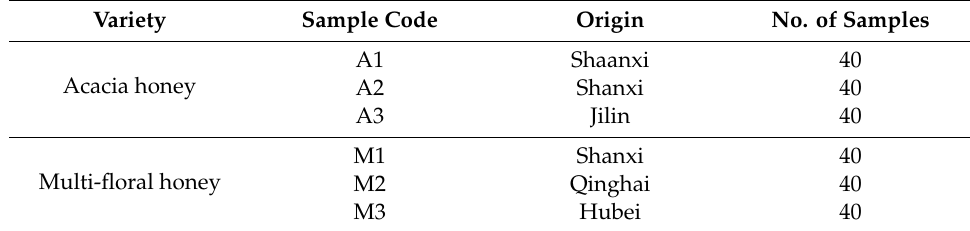
Table 1. General information of honey